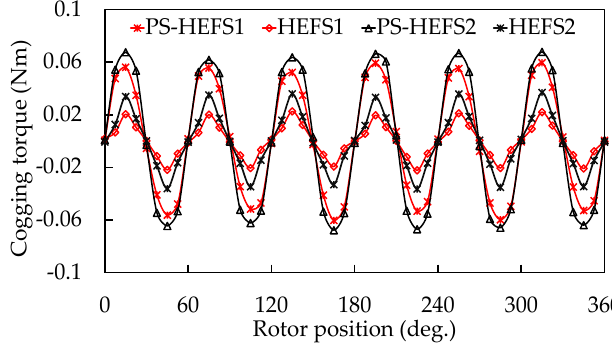
Figure 14. Predicted cogging torque waveforms.